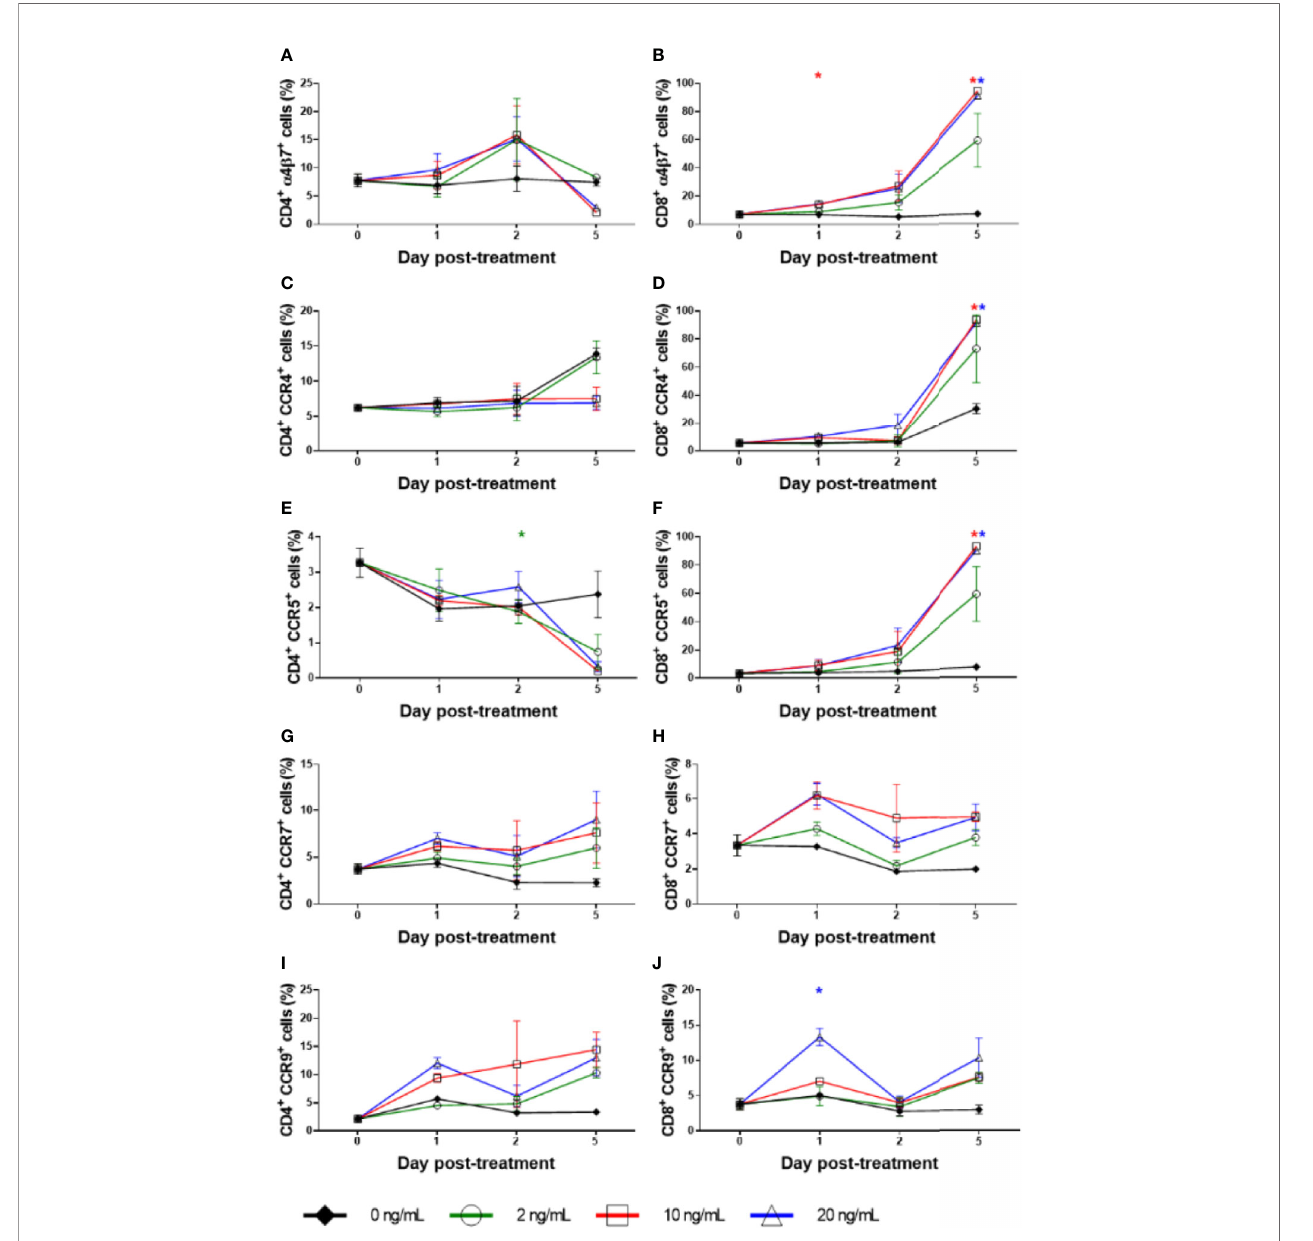
FIGURE 9 | Homing marker expression with RMD treatment in vitro . The expression percentage of a 4 b 7 + on (A) CD4 + and (B) CD8 + , CCR4 + on (C) CD4 + and (D) CD8 + , CCR5 + on (E) CD4 + and (F) CD8 + , CCR7 + on (G) CD4 + and (H) CD8 + , and CCR9 + on (I) CD4 + and (J) CD8 + with increasing dosages of RMD (0, 2, 10, and 20 ng/ml); animal number: n = 3. Asterisks indicate statistical signi fi cance of means to baseline as shown with concentration color (p <